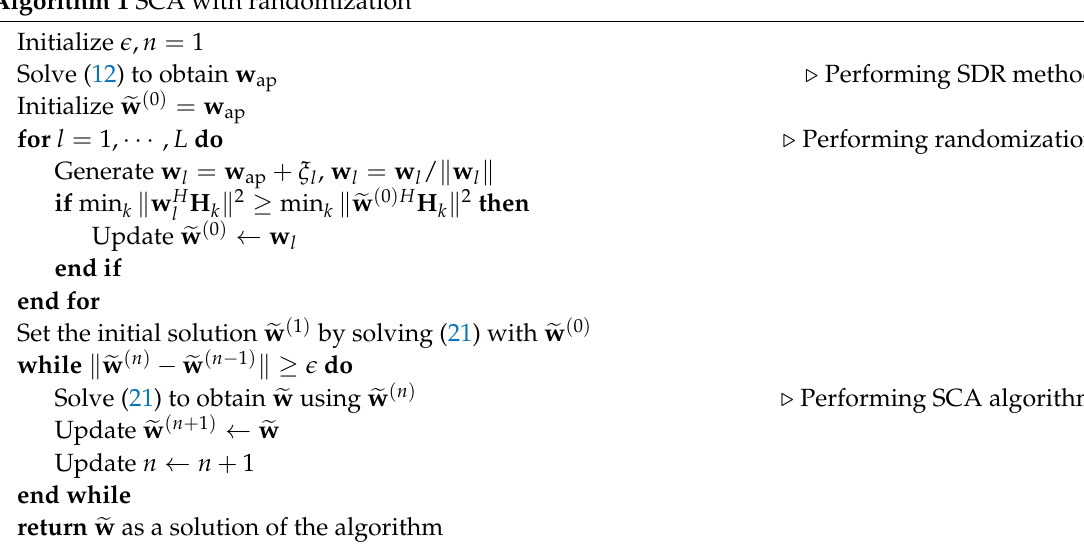
Algorithm 1 SCA with